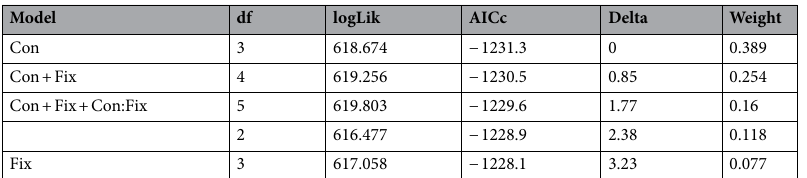
Table 3. Full and nested models ordered according to AICc. df degrees of freedom, logLik log likelihood, AICc Akaike Information Criterion corrected for small sample sizes, delta difference of AICc compared to the best model; weight: probability that the model explains the dataset; Con The model includes connectivity, Fix The model includes the number of fixed individuals at the start, Con:Fix The model includes the interaction term between the two independent